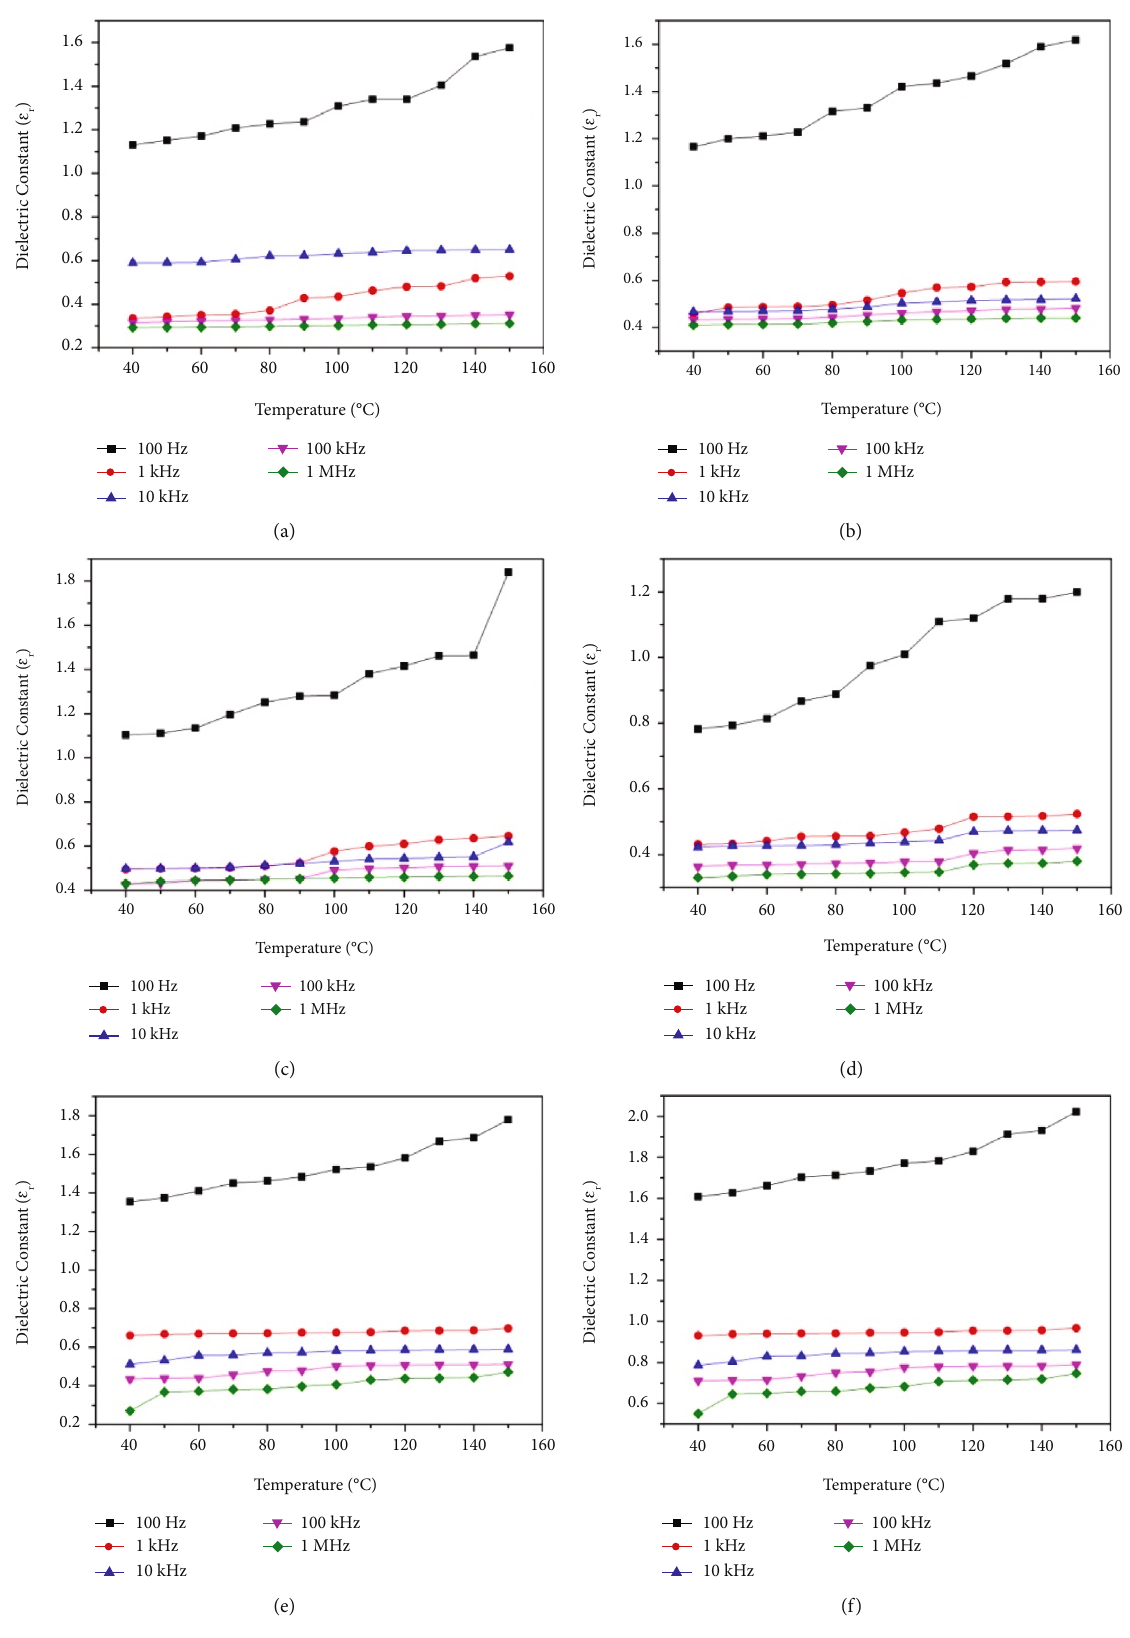
Figure 5: Dielectric constant as a function of temperature and frequency for (a) sample A, (b) sample B, (c) sample C, (d) sample D, (e) sample E and (f) sample